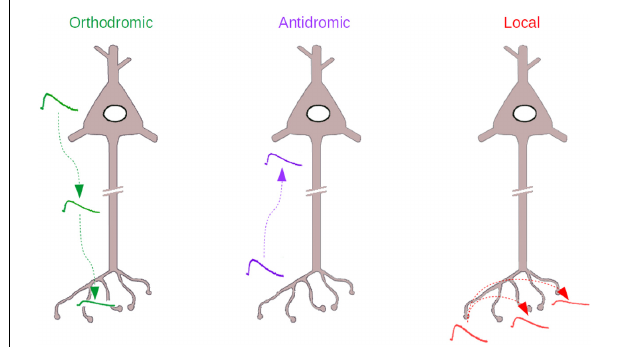
FIGURE 1 | The three types of Analog signaling that have been described in the literature. Left , the orthodromic signaling, where somatodendritic voltage changes propagate to the axon. Middle , the antidromic signaling, where axonal voltage changes propagate backward to the axon initial segment and soma. Right , the local signaling, where axonal voltage changes propagate within the axon, to other varicosities, without escaping from the axonal